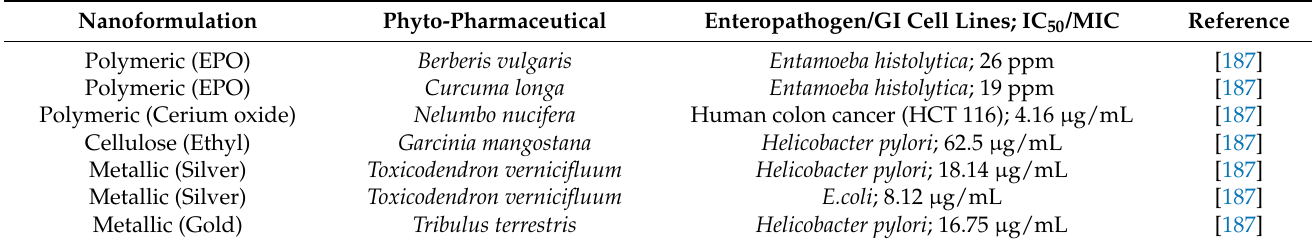
Table 3. Nano-phytopharmaceuticals for therapeutic applications in GI